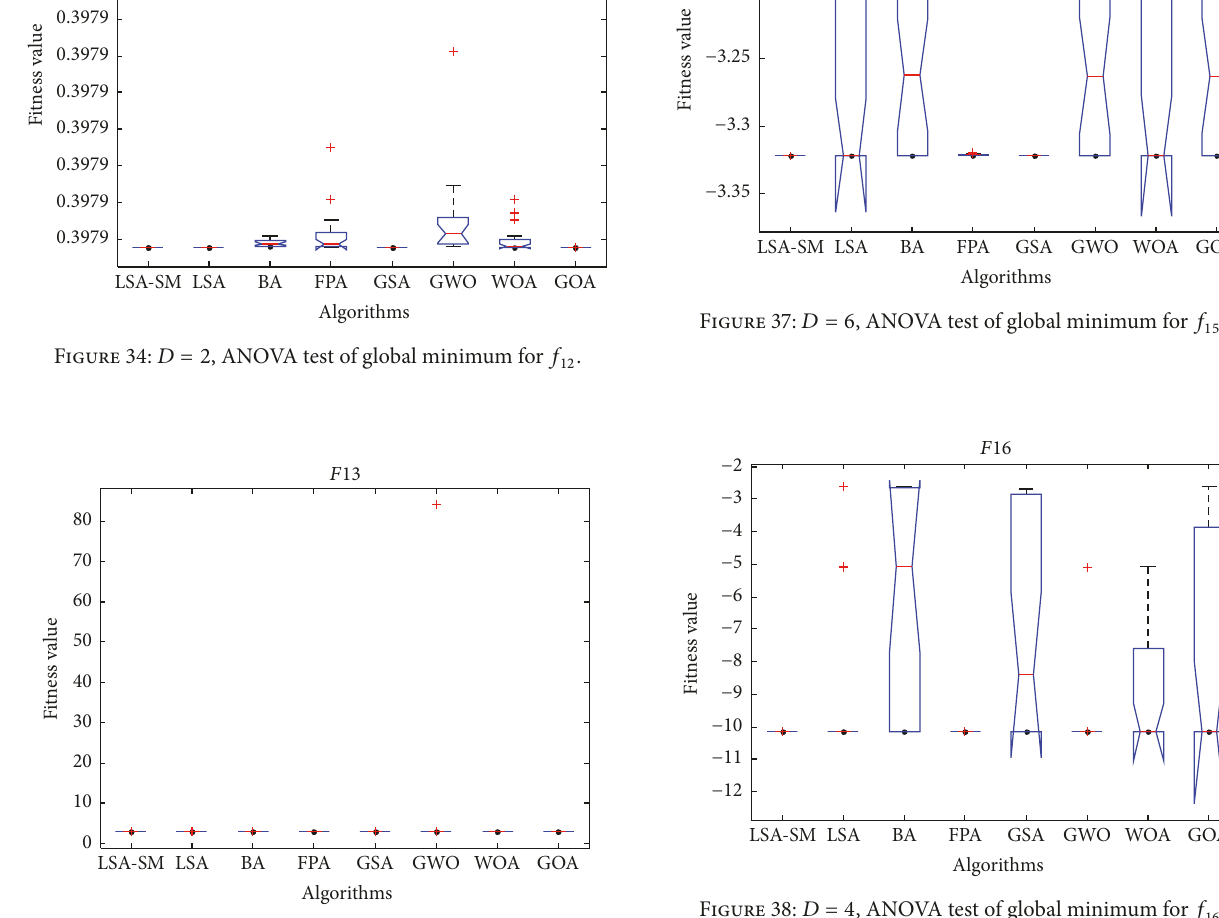
Figure 35: 𝐷 = 2 , ANOVA test of global minimum for 𝑓 13 .